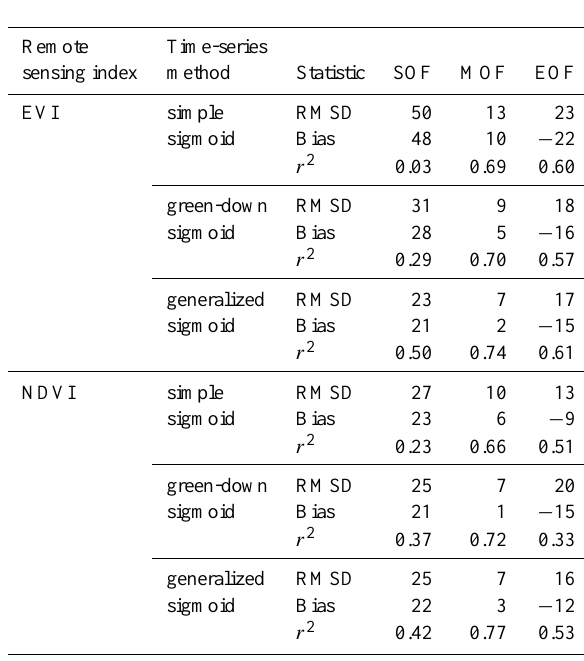
Table 5. Statistics comparing remote-sensing-derived to redness- derived near-surface phenology. Statistics are reported as in Table 4. Smoothing and interpolation was used to estimate dates from near- surface redness time series, while the time-series method indicated in the table refers to analysis of remote sensing indices.